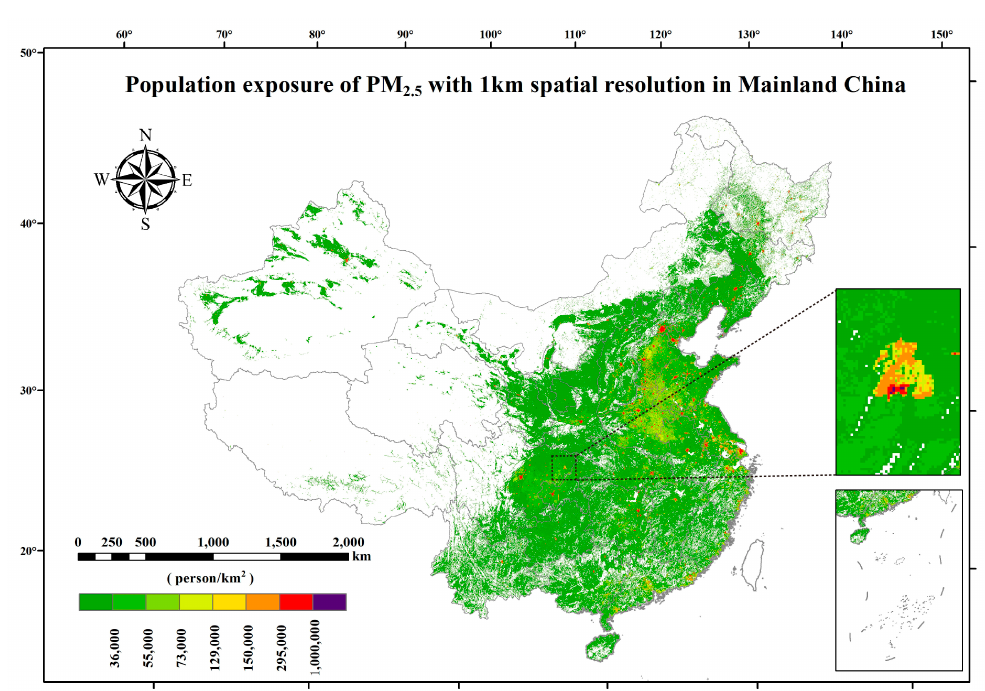
Figure 4. Gridded population exposure to PM 2.5 in mainland China in 2014 with a spatial resolution of 1 km. Blank in the figure means areas without population exposure to PM 2.5 .